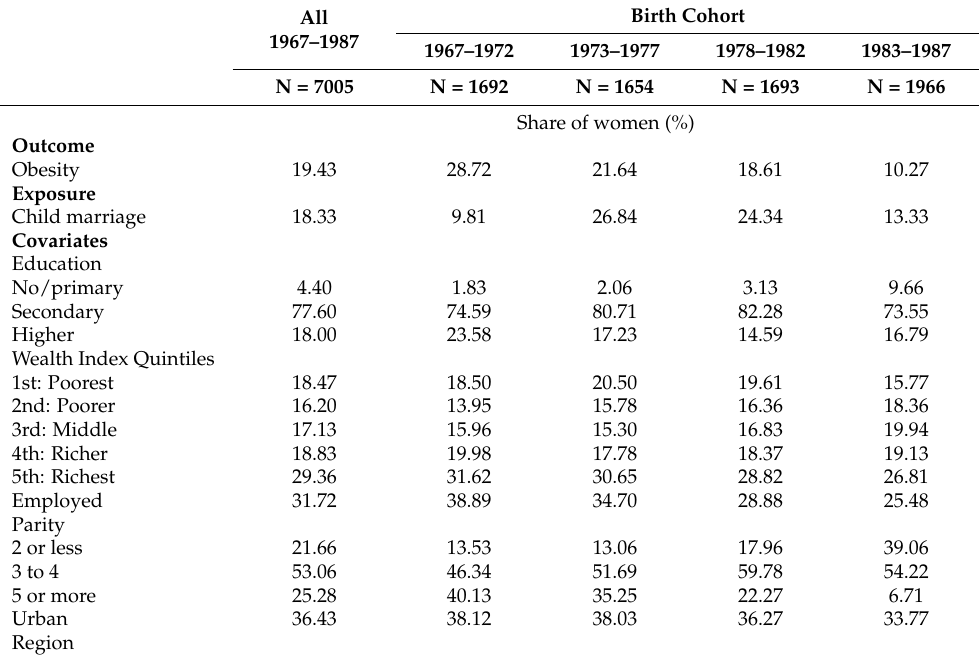
Table 1. Descriptive statistics by birth